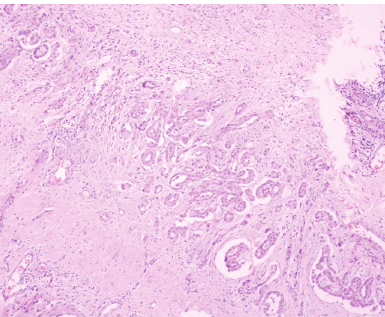
Figure 2: Intermediate-power view of complex, interconnect- ing pseudoglandular mesothelial proliferation spraying out into abortive tubular structures and rare isolated cells in a desmoplastic stroma. Neoplastic mesothelial cells are characterised by higher nucleus/cytoplasm ratio than normal cells and have prominent nucleoli and eosinophilic cytoplasm disposed into strands with nuclear overlapping ( × 100 magnification; H&E staining).